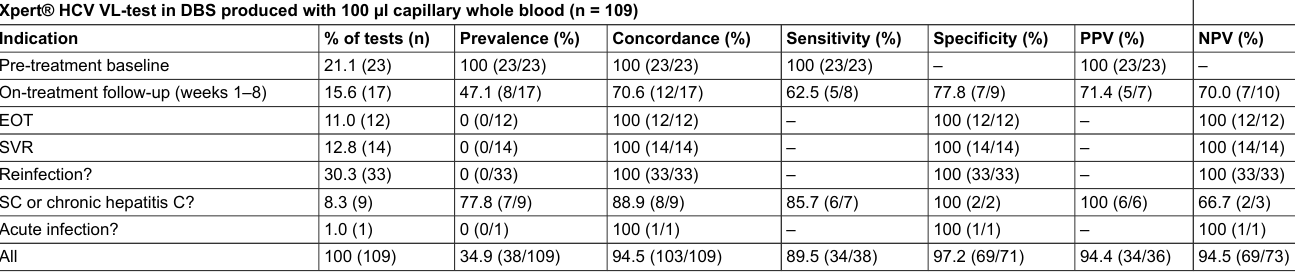
Table 3: Performance according to indication (Xpert ® HCV Viral Load (VL) test in dried blood